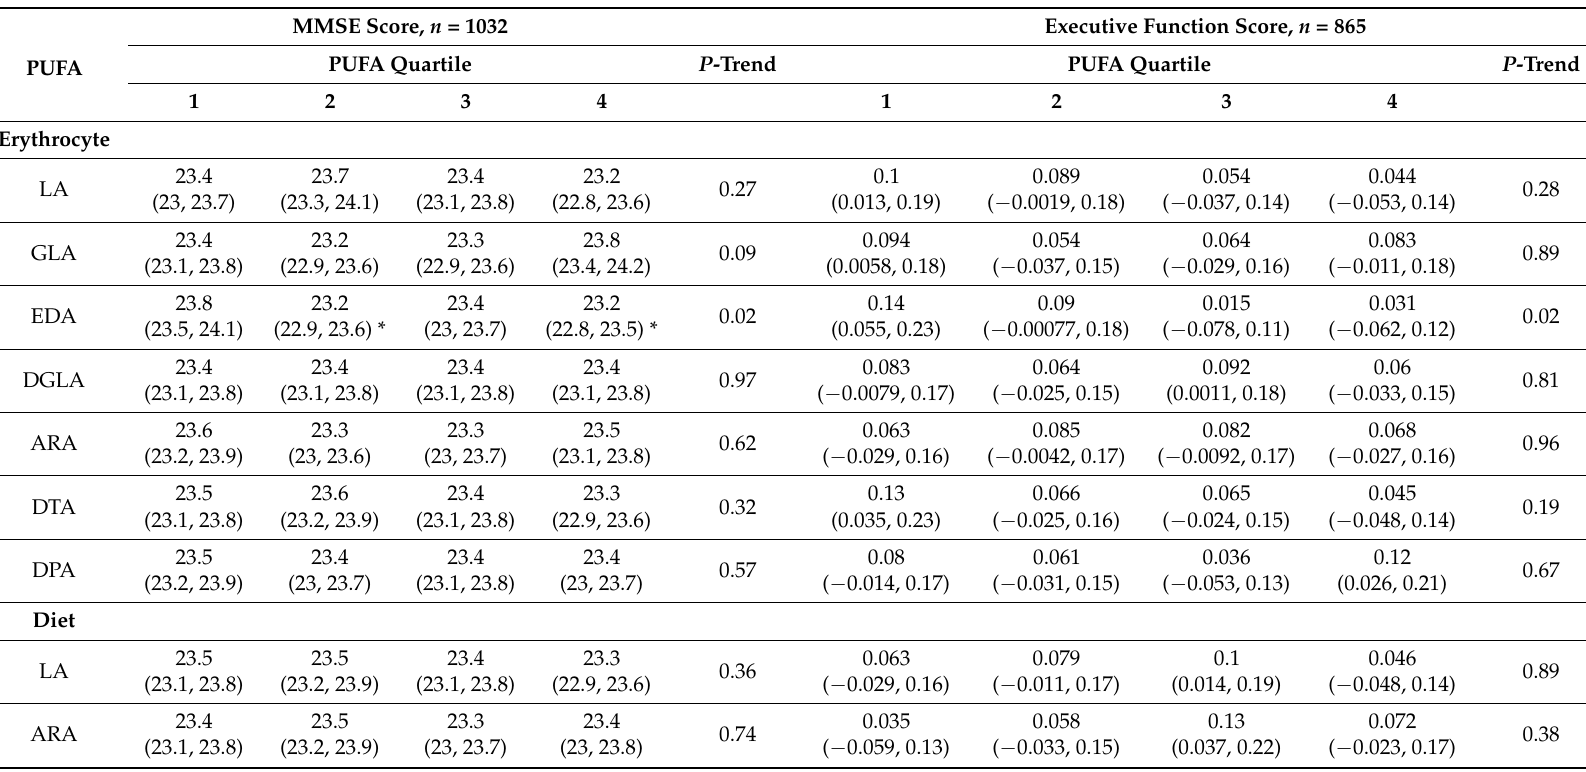
Table 3. Associations of n- 6 PUFA erythrocyte composition and dietary intake (quartiles) with 2-year MMSE and executive function scores, adjusted for baseline scores a,b